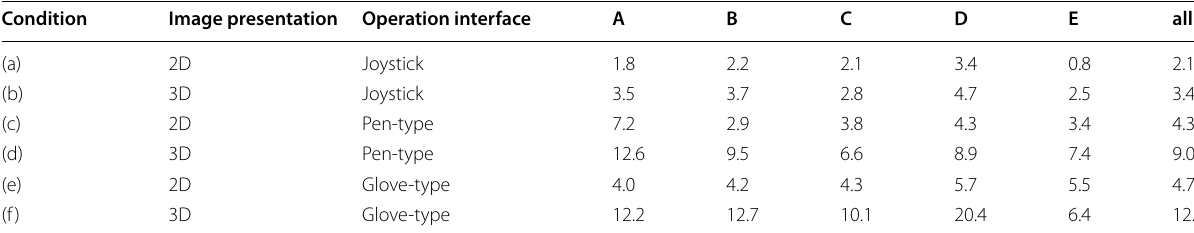
Condition Image presentation Operation interface